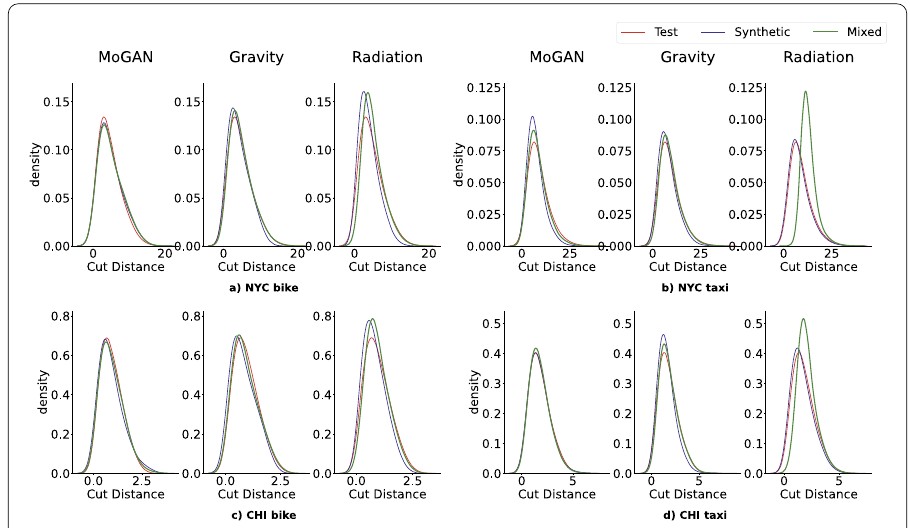
Figure 3 Results for the Cut Distance. Distributions of the pairwise cut distances between mobility networks in the test set (red), synthetic set (blue), and mixed set (green), for the four datasets. For each dataset, we compare the overlap among the distributions of MoGAN and the two baselines (Gravity and Radiation). The Radiation model’s mixed and synthetic sets distributions significantly differ from the test set for all datasets. In contrast, the Gravity model clearly outperforms the Radiation model for all